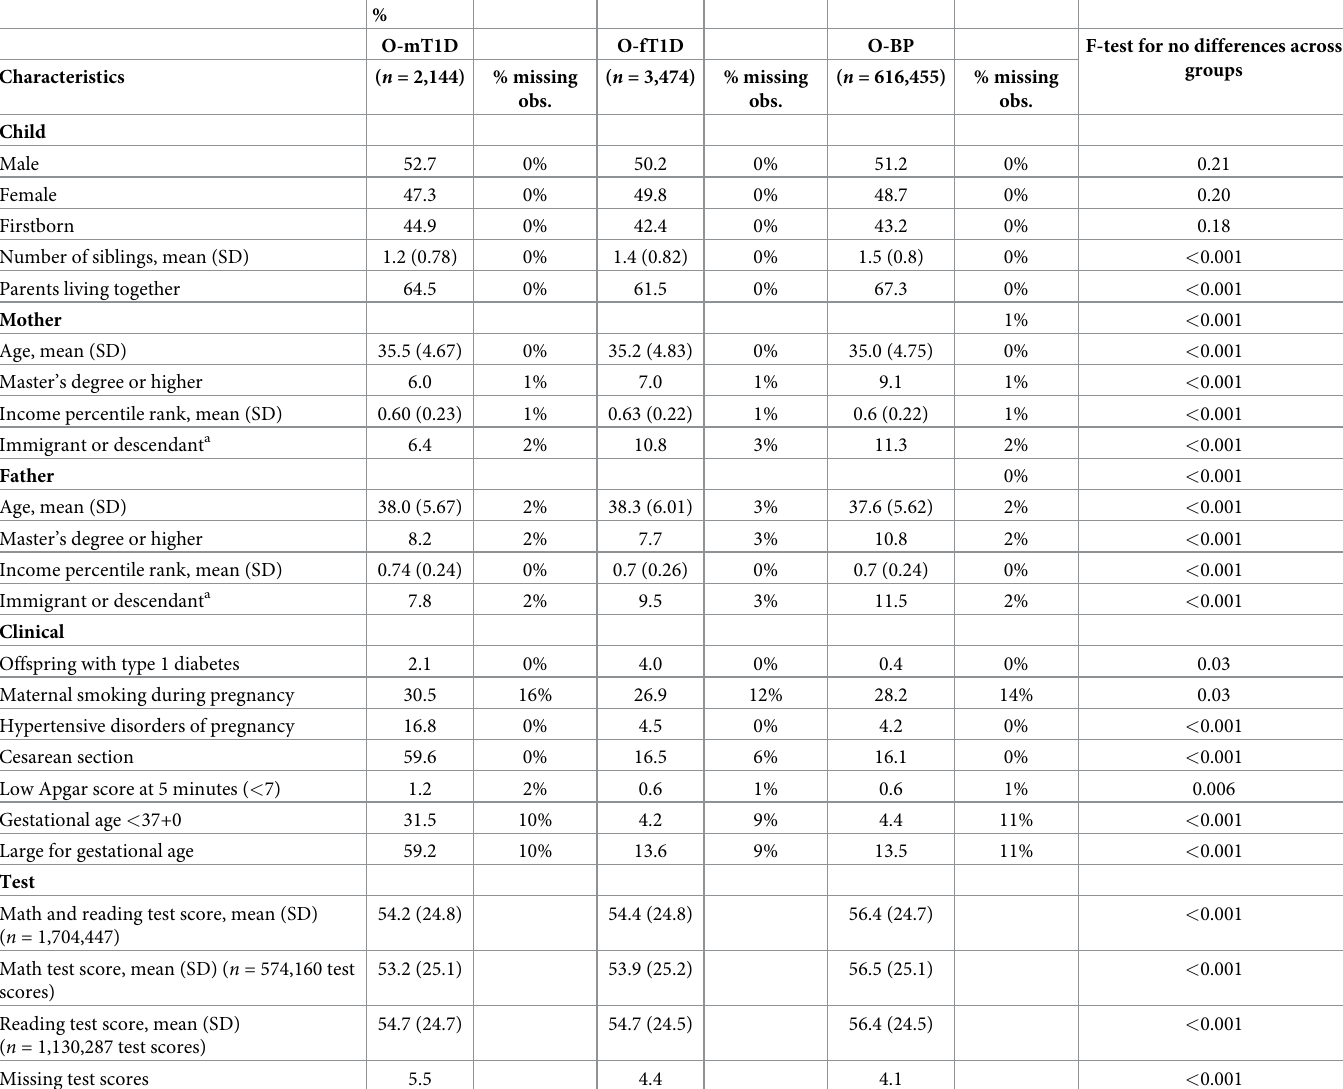
Table 1. Descriptive statistics of study